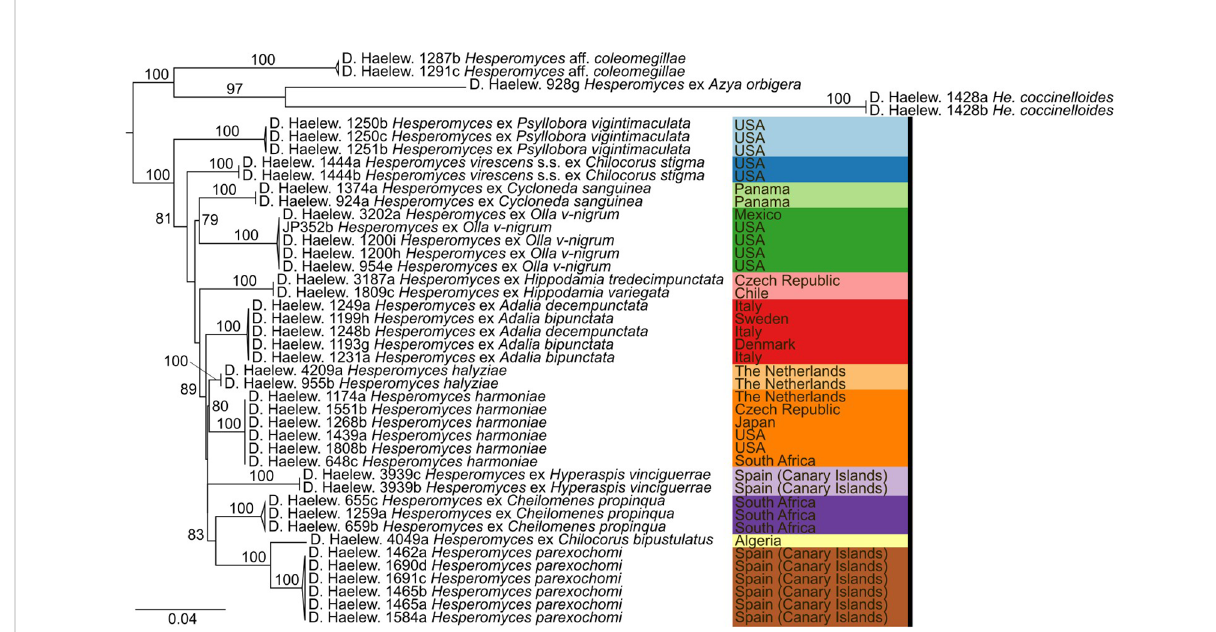
FIGURE 2 Phylogenetic tree obtained from the maximum likelihood (ML) analysis of a two-locus (ITS – LSU) dataset. For every node, the ML bootstrap value ( ≥ 70) is given above or next to the branch leading to that node. Species within the Hesperomyces virescens complex are each indicated with their own color, as in Figure